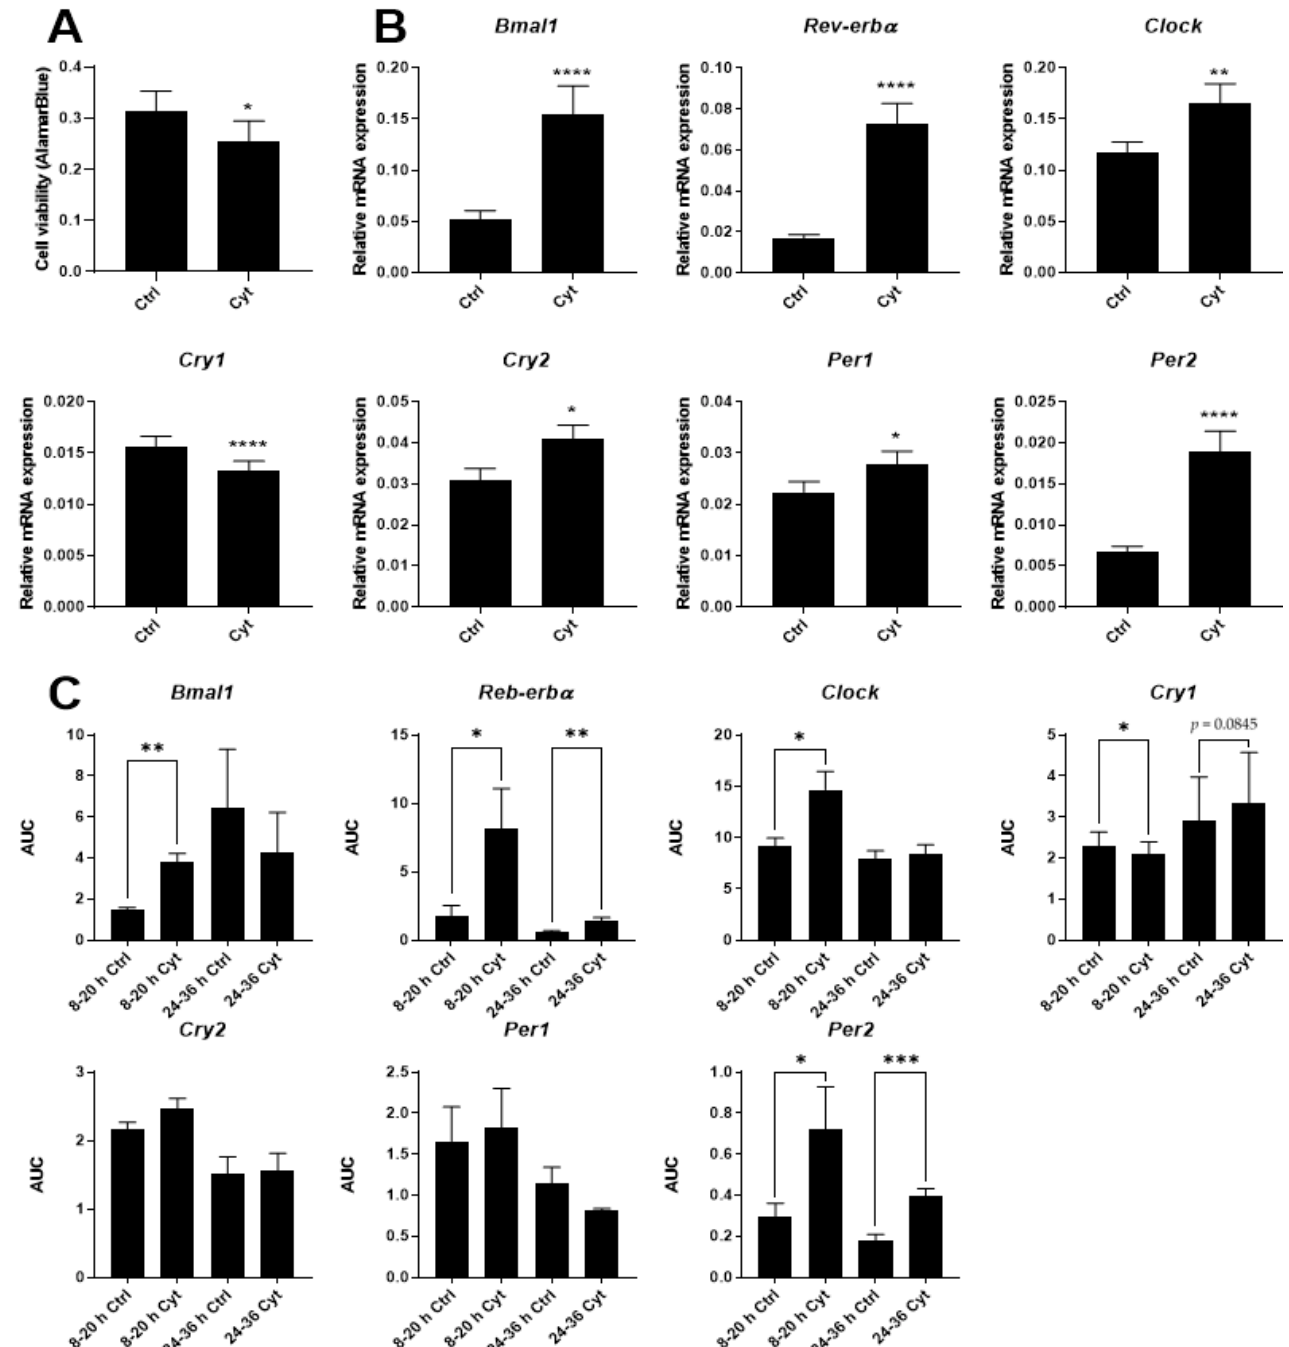
Figure 3. IL-1 β and IFN- γ mediate differential but uncoordinated alterations in the expression of core clock genes in non-synchronized INS-1 cells. INS-1 cells were exposed to 150 pg/mL mouse IL-1 β + 0.1 ng/mL rat IFN- γ (Cyt) for either 12 h ( A , B ) or at 4 h intervals from 8–36 h ( C ). ( A ) Cell viability was assessed using AlamarBlue ( n = 4). (B) Relative mRNA expression is calculated using 5S rRNA and Hprt1 as reference genes. Values are means ± SEM ( n = 6). ( C ) Relative mRNA expression is calculated using Hprt1 as reference genes. The time-dependent response of cytokine treatment was divided into two intervals consisting of the 8–20-h and 24–36-h intervals, from which areas under the curve (AUC) were calculated and used for subsequent statistical analysis. Values are means ± SEM ( n = 5). Statistics are paired Student’s t -test. Significance levels were annotated as follows: * = p -value < 0.05, ** = p -value < 0.01, *** = p -value < 0.001, **** = p -value < 0.0001.